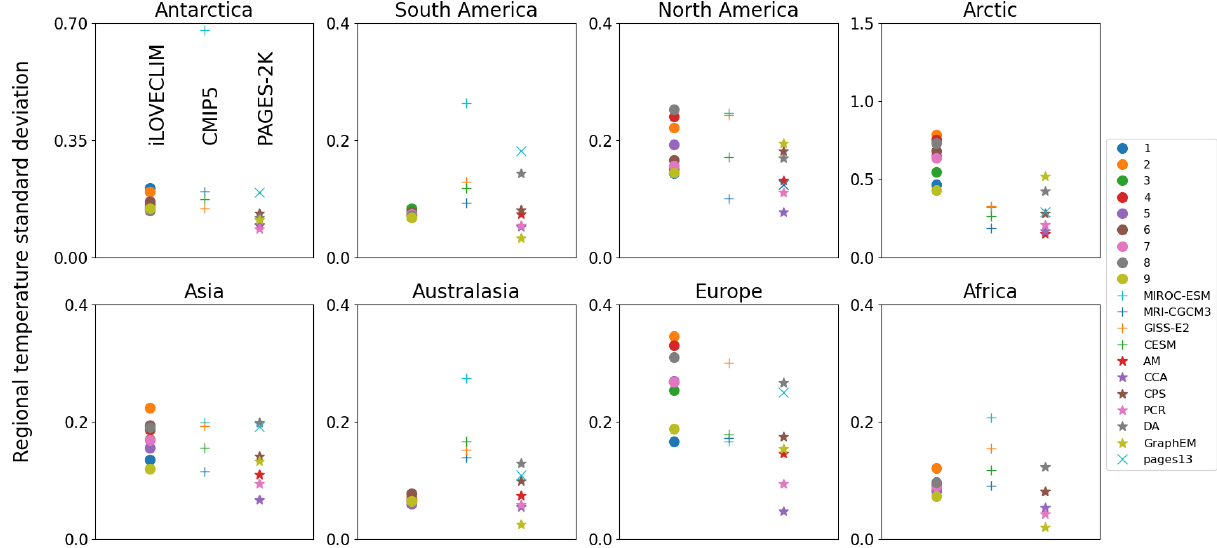
Figure 1. Temperature variability (standard deviation in K) for different continental regions. Shown are the nine i LOVECLIM ensemble members (left), results for the CMIP5 simulations (middle), ensemble means for the six different CFR-based results from the PAGES-2k data set (right; Neukom et al., 2019) and the temperature variability based on the original PAGES-2k time series (Ahmed et al., 2013) for the continental-scale regions for which this data are available. For North America, both the pollen-based and tree-based results are shown. For the CESM results we show the mean of the standard deviation over the ensemble. Note the different y axes. A 50-year Butterworth filter was applied to all results except for the original PAGES-2k time series, which are 30-year averages.